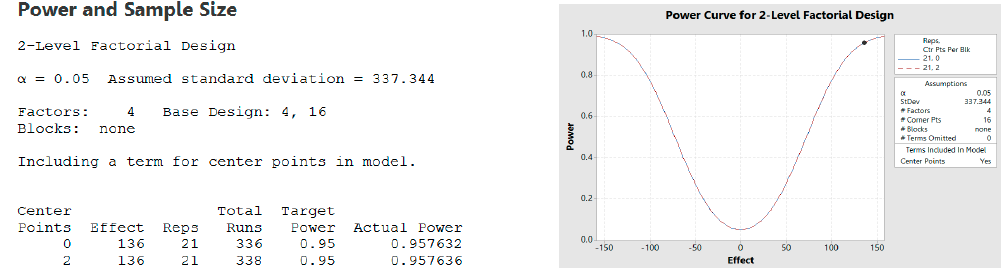
Figure 8. Power curve and sample size for 2-level factorial design.